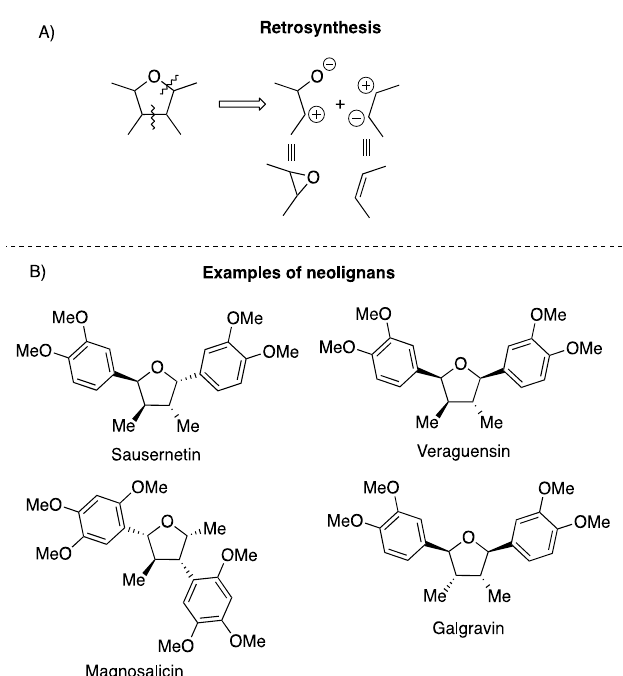
Figure 1. ( A ) Retrosynthesis of tetrahydrofurans. ( B ) Examples of neolignans.